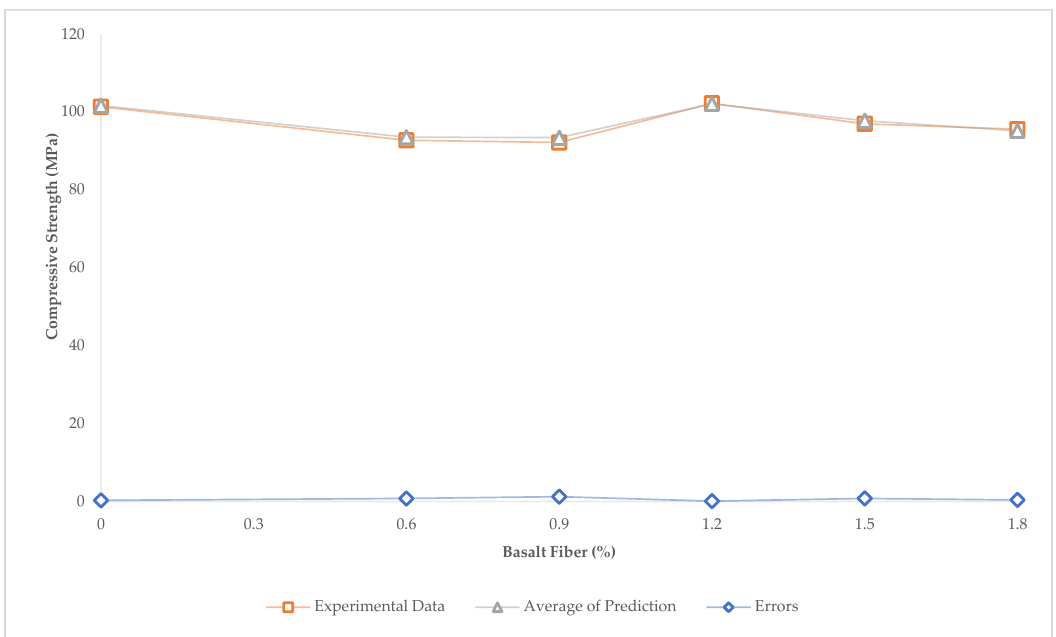
Figure 17. Compressive Strength Prediction, and Experimental Data.